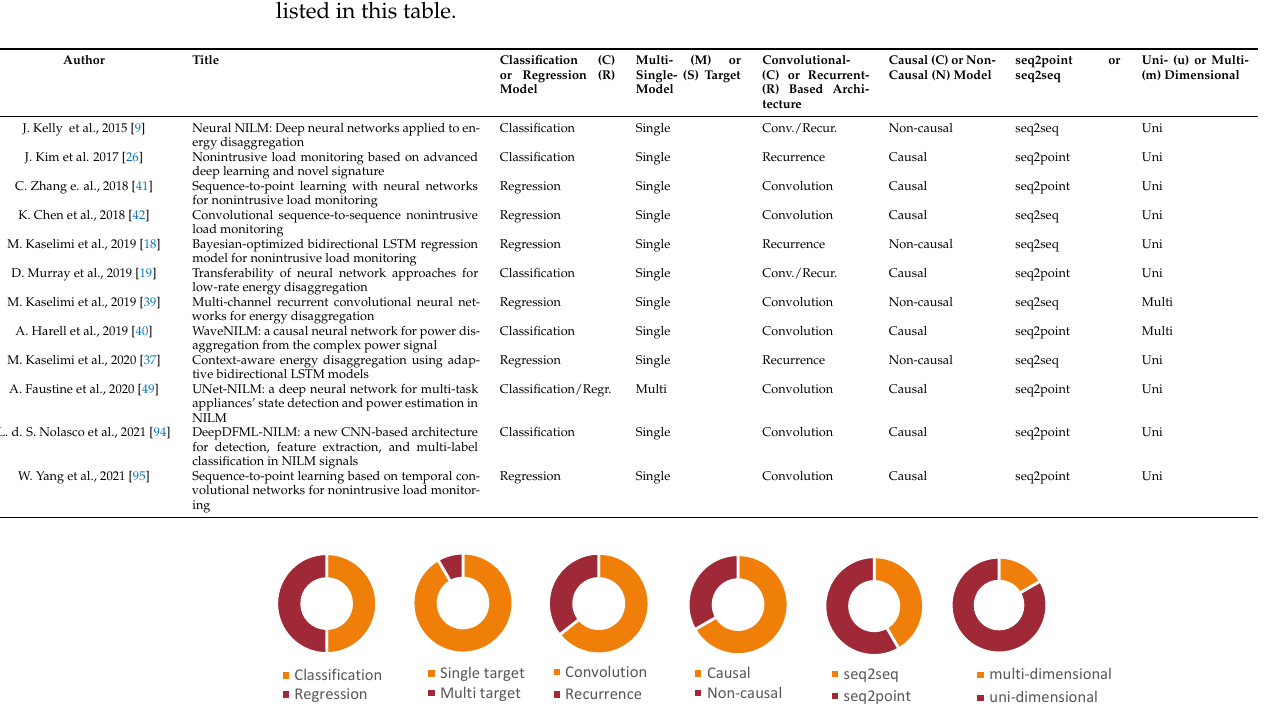
Figure 9. Pie charts with the final choices between the different NILM research dilemmas, based on the research works mentioned in Table